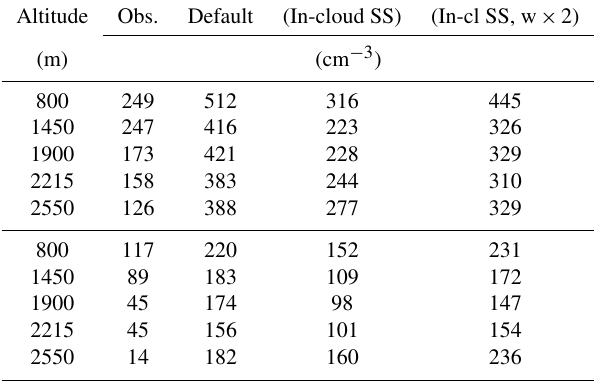
Table 5. Mean in-cloud cloud droplet number concentration in the three simulations in Figs. 10 and 11 (original, supersaturation cor- rected in clouds, and supersaturation corrected and updraught speed increased) and in the observations from the FAAM aircraft cloud droplet probe. Model grid boxes and CDP observations where the liquid water content exceeds 0.15gkg − 1 are shown above the hori- zontal line and those with lower liquid water contents below. Altitude